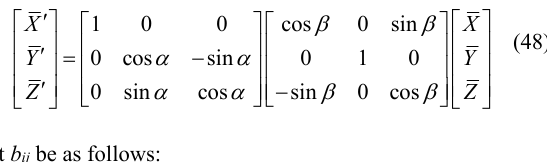
Figure 2. Sphere S and its small circle